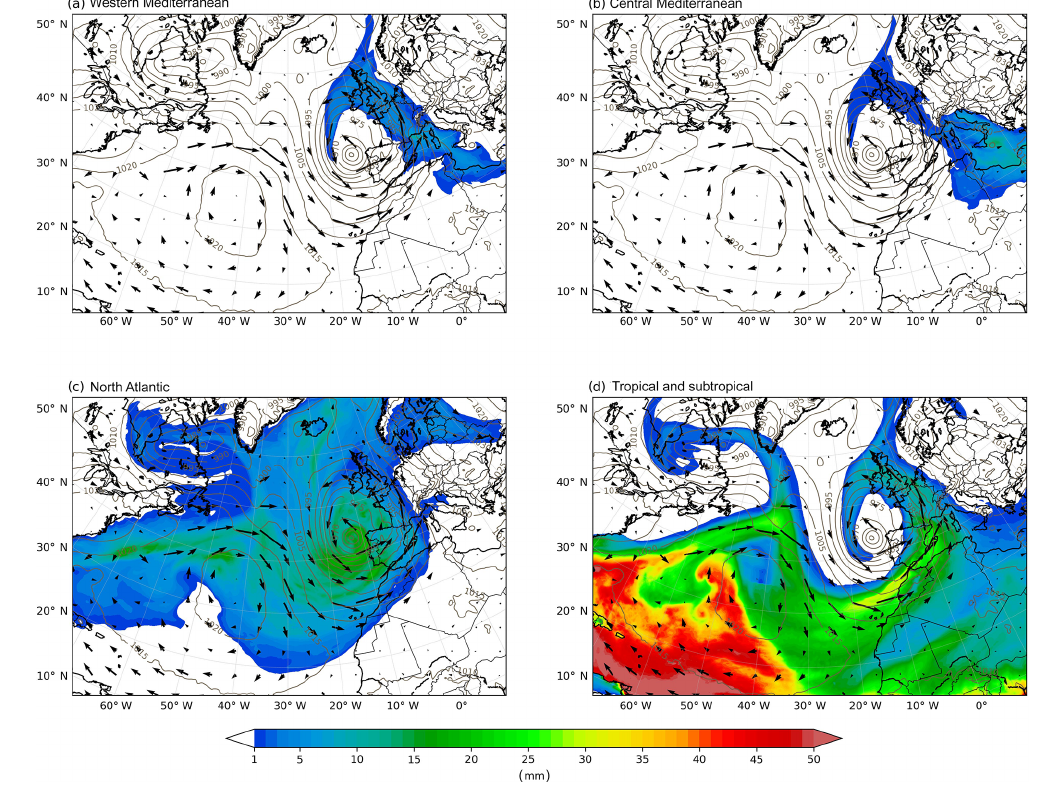
Figure 10. Similar to Fig. 5, but for 7 November at 12:00UTC.